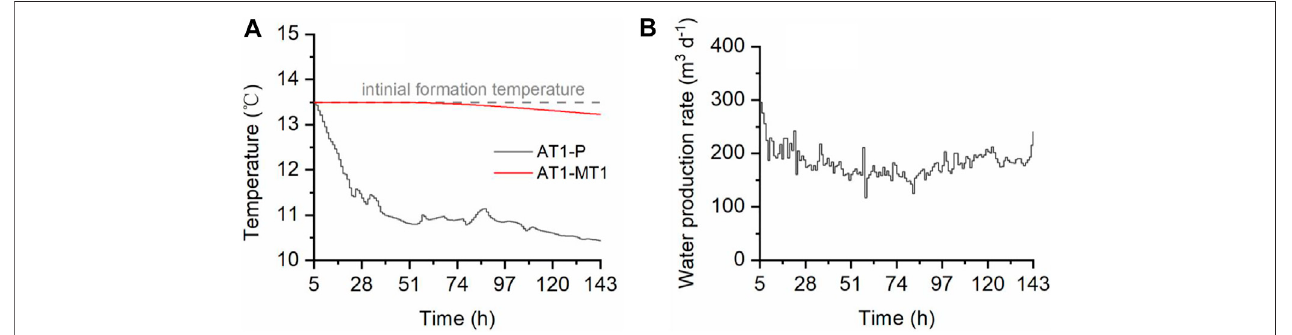
FIGURE2| Dataused for calculation. (A) Processeddownhole temperature dataofproduction well AT1-P and monitoring wellAT1-MT1fromthe sensor installed 10 m below the top of the methane hydrate-concentrated zone. (B) Processed water production data from production well AT1-P.